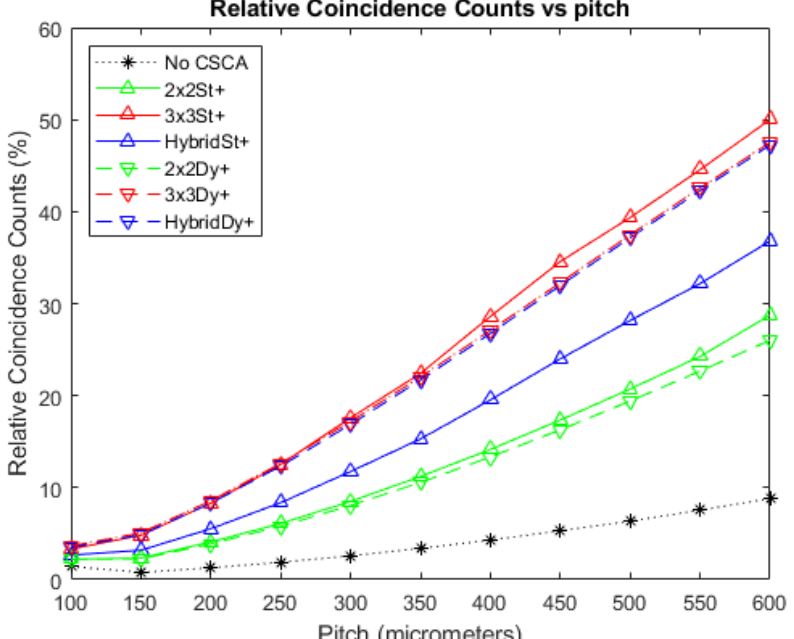
Figure 10. A plot of RCC versus pixel pitch at an incident photon flux of 10 7 photons mm −2 s −1 . The dynamic Hybrid and dynamic 3 × 3 CSCAs overlap significantly with each other at all pitches, and with the static 3 × 3 CSCA at pitches below ~300 µ m. Similarly, the 2 × 2 dynamic and static CSCAs overlap at low pitches (below ~300 µ m) but begin to become distinguishable at the higher pitches considered here. The case where no CSCA is applied is also shown as a reference.